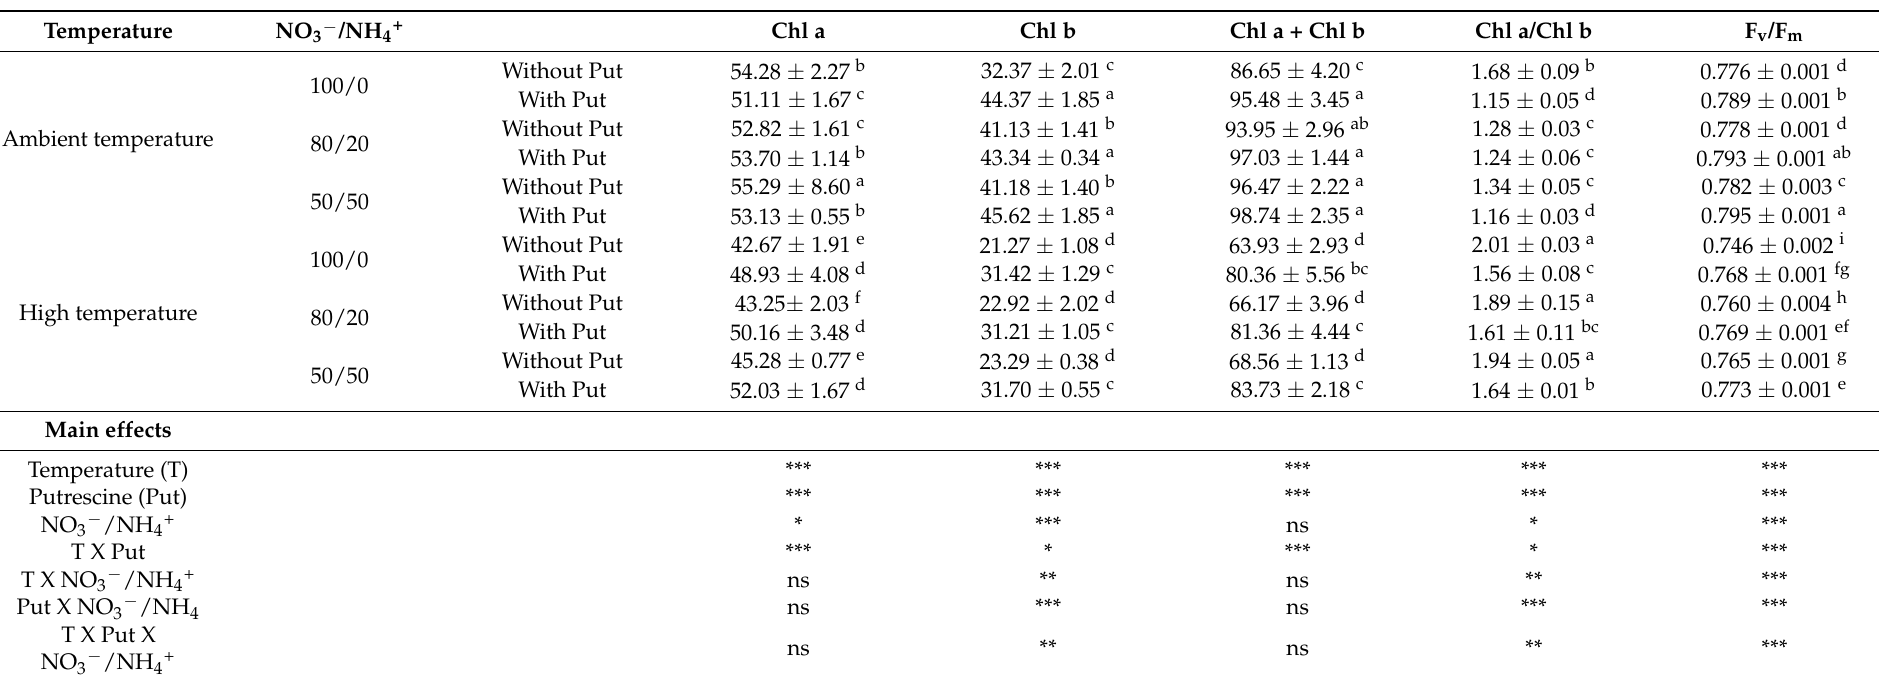
Table 2. Effect of foliar application of putrescine on concentrations of chlorophylls (mg 100 g − 1 FW) in outer leaves of the cauliflower cv. Moonshine at different ration of NO 3 − /NH 4+ and